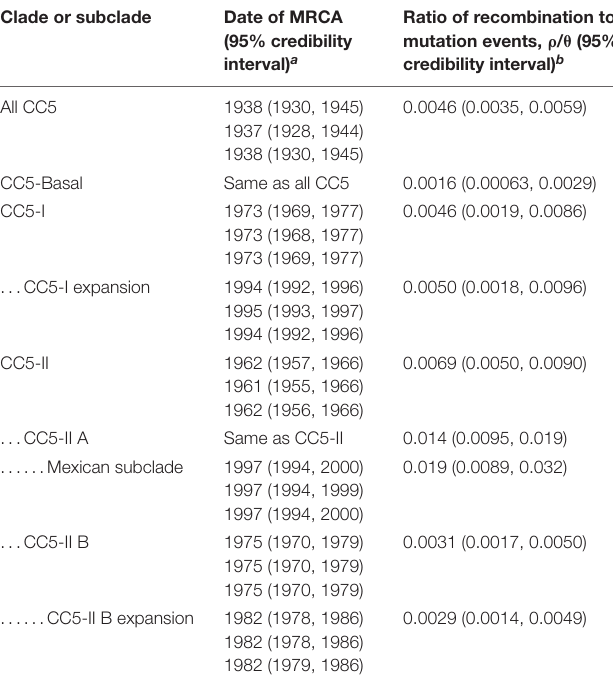
TABLE 1 | Rates of evolution and dates of CC5 clades. Clade or